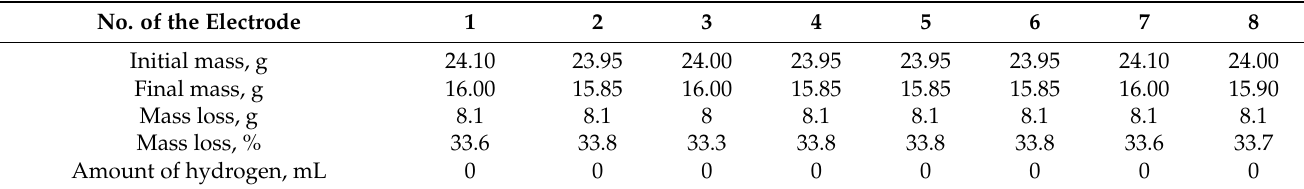
Table 3. Results of etching in sulfuric acid of oxide–nickel electrodes battery